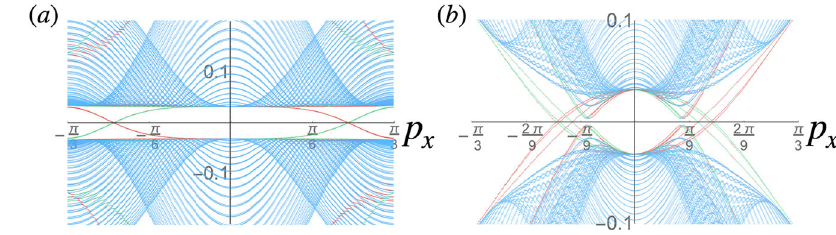
Fig. 5 | Edge modes in the BdG spectrum of the Hofstadter SC for q =3. Cylindrical boundary conditions open in the y direction were taken for the self- similar ^ T x ^ T y symmetric gap function Eq. (12) at a 5/6 and b 1/6 fi lling (chemical potential μ =±2.44, respectively, with t =1 and Δ 0 =0.02 in a and 0.2 in b , taking 100 extended unit cells along the y direction; see Methods for details of the BdG Hamiltonian and Supplementary Material for more details of the calculation). The spectra are colored according to a weighted inverse participation ratio with green and red indicating states localized to the top and bottom edges of the cylinder, Indeed,theSCphasewe fi ndinthetopandbottombandssatis fi es Δ ð 0 Þ